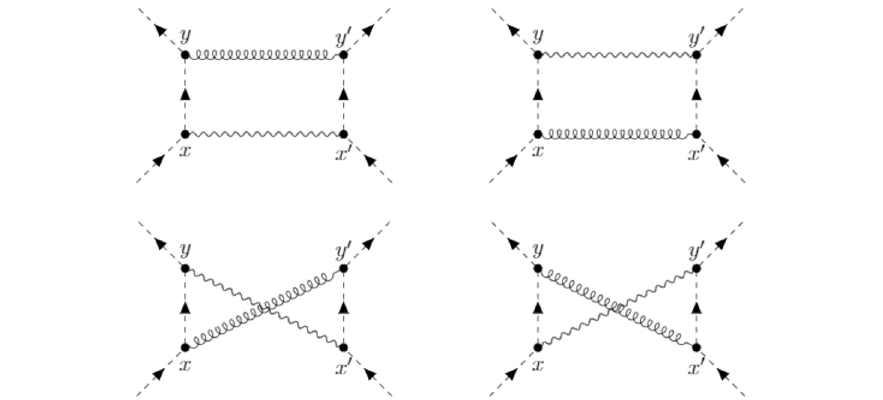
Figure 5 . These diagrams show the contributions from correlations between the source (primed) and observer (unprimed). Dashed lines represent massive scalars, wavy lines represent photons and curly lines represent gravitons. These graphs have the same topology as Bjerrum-Bohr’s Diagram 2